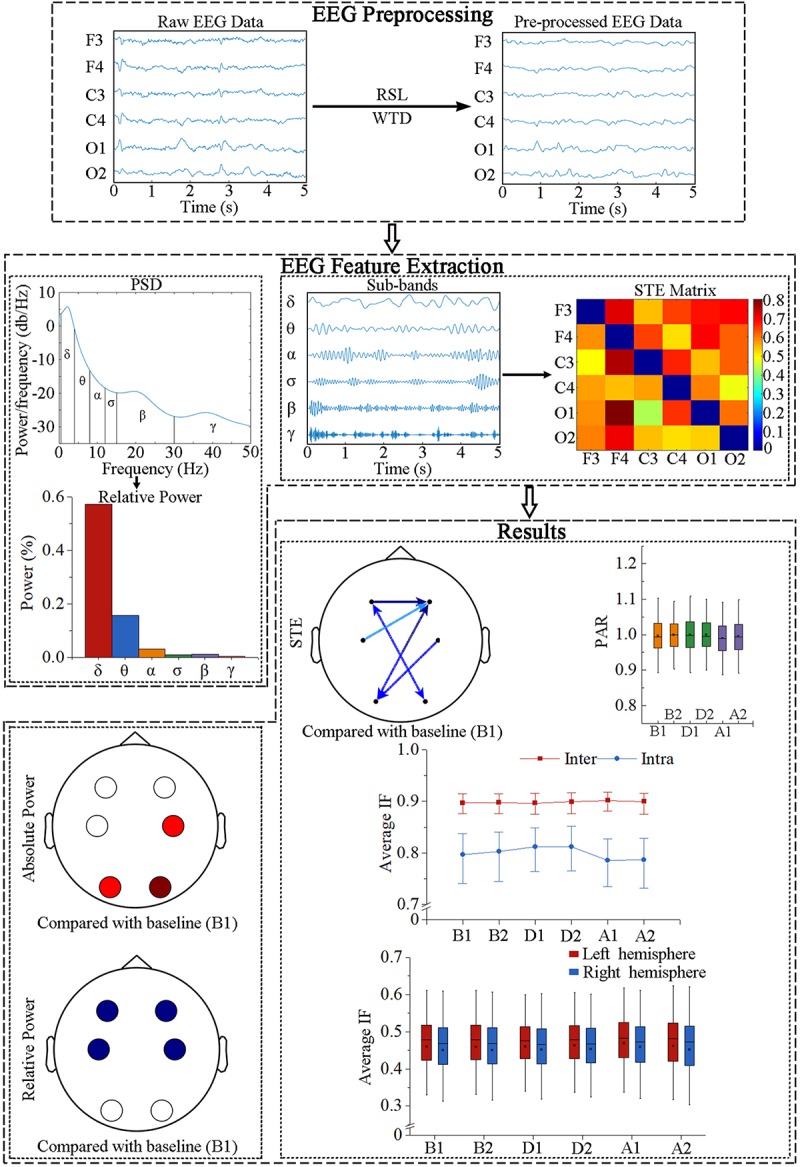
Flow diagram of EEG data processing. RLS, recursive least squares; WTD, wavelet threshold denoising; PSD, power spectral density; STE, symbolic transfer entropy; PAR, posterior-to-anterior ratio; IF, information flow.